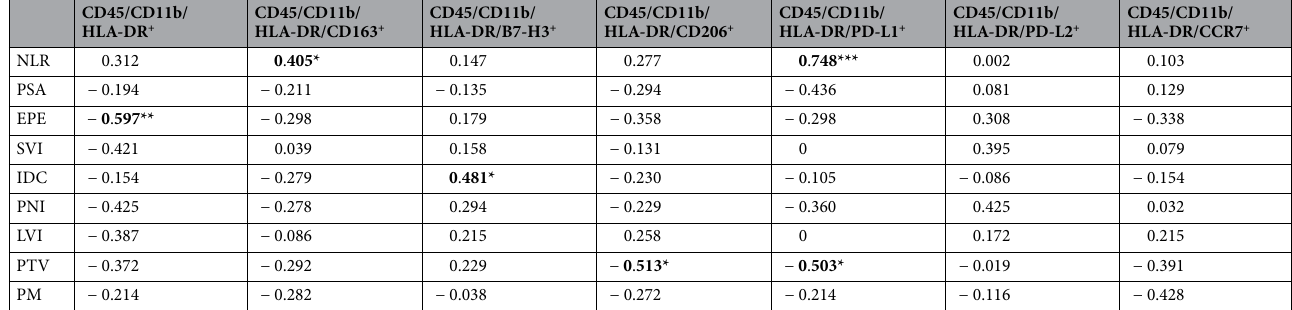
Table 1. Correlation between clinico-pathological characteristics and macrophage-associated markers within the macrophage population. Spearman’s rank correlation table showing the correlation between clinico-pathological characteristics and the proportion of cells expressing high levels of M1-associated marker (CCR7), M2-associated markers (CD163, CD206) or immune checkpoints (B7-H3, PD-L1 or PD-L2) within the macrophage (CD11b + HLA-DR + CD45 + ) population. Spearman’s rank correlation coefficients are presented below. Correlation coefficients (r s ) > 0.3 or < − 0.3 with significant p-values are highlighted in bold. NLR Neutrophil-to-lymphocyte ratio, PSA Prostate specific antigen, EPE Extraprostatic extension, SVI Seminal vesicle invasion, IDC Intraductal carcinoma of the prostate, PNI Perineural invasion, LVI Lymphovascular invasion, PTV Prostate tumor volume, PM Positive margin. *p ≤ 0.05, **p ≤ 0.01, ***p ≤